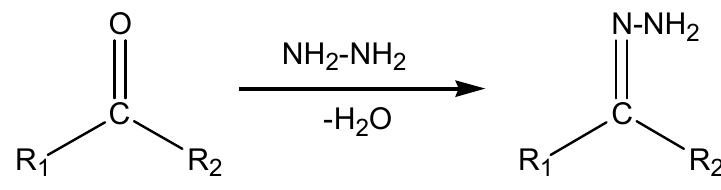
Scheme 1. General formation and formula of hydrazines.